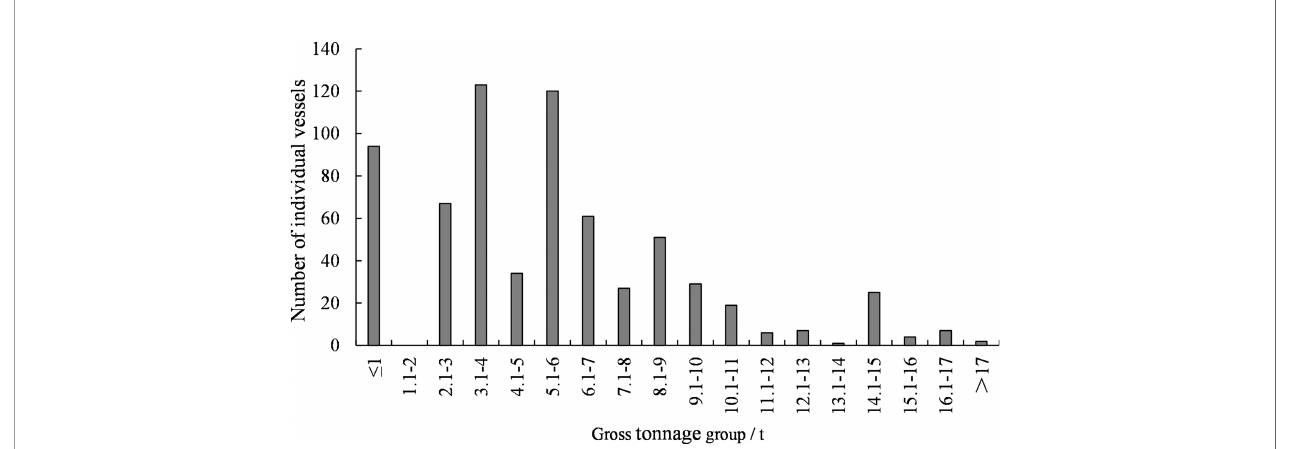
FIGURE 4 | Number of vessels per gross tonnage category (in tons) for small-scale fi sheries in Shengsi Country.